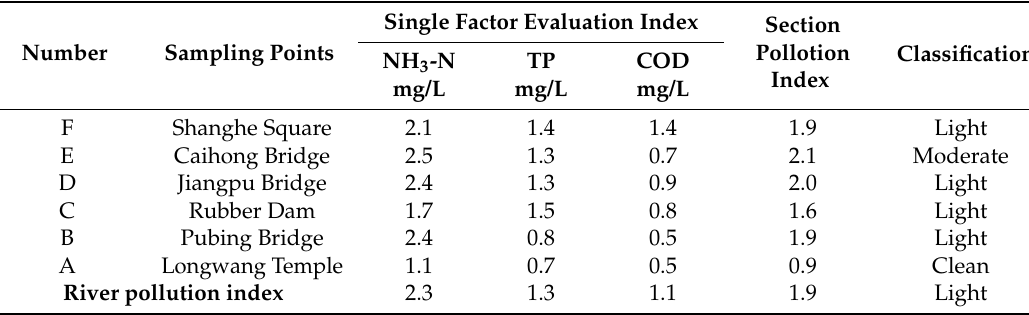
Table 6. Water Quality Evaluation of Chengnan River with Nemerow Index Method after